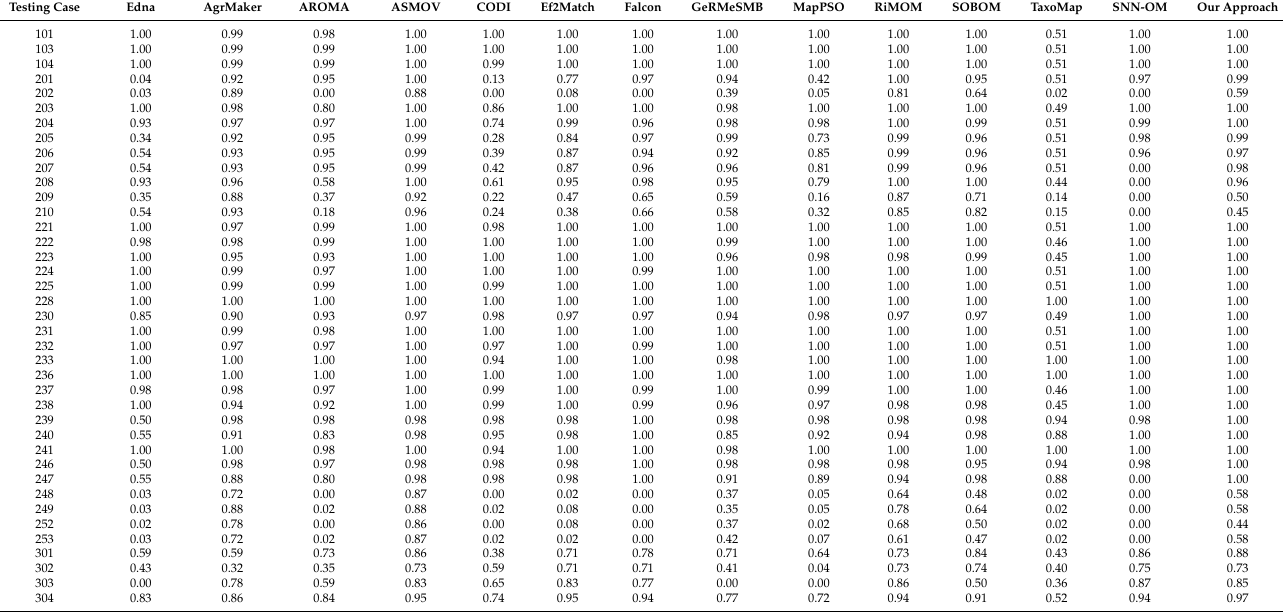
Table 11. Comparison With OAEI’s Participants On OAEI’s